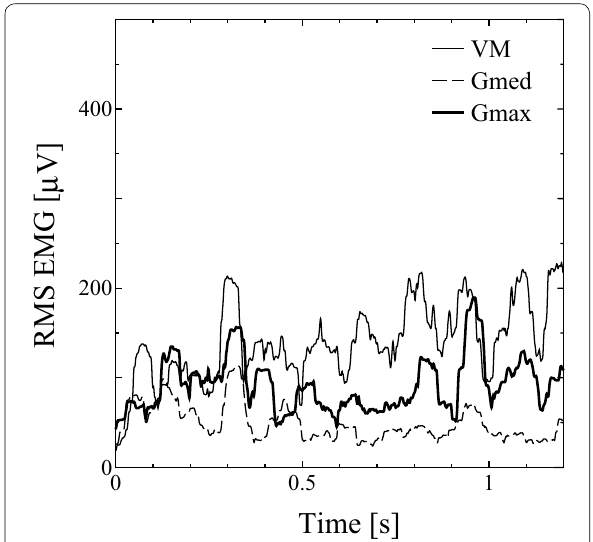
Fig. 24 RMS EMG of an ACL reconstructed subject during isokinetic exercise. The target speed was 0.25 m/s